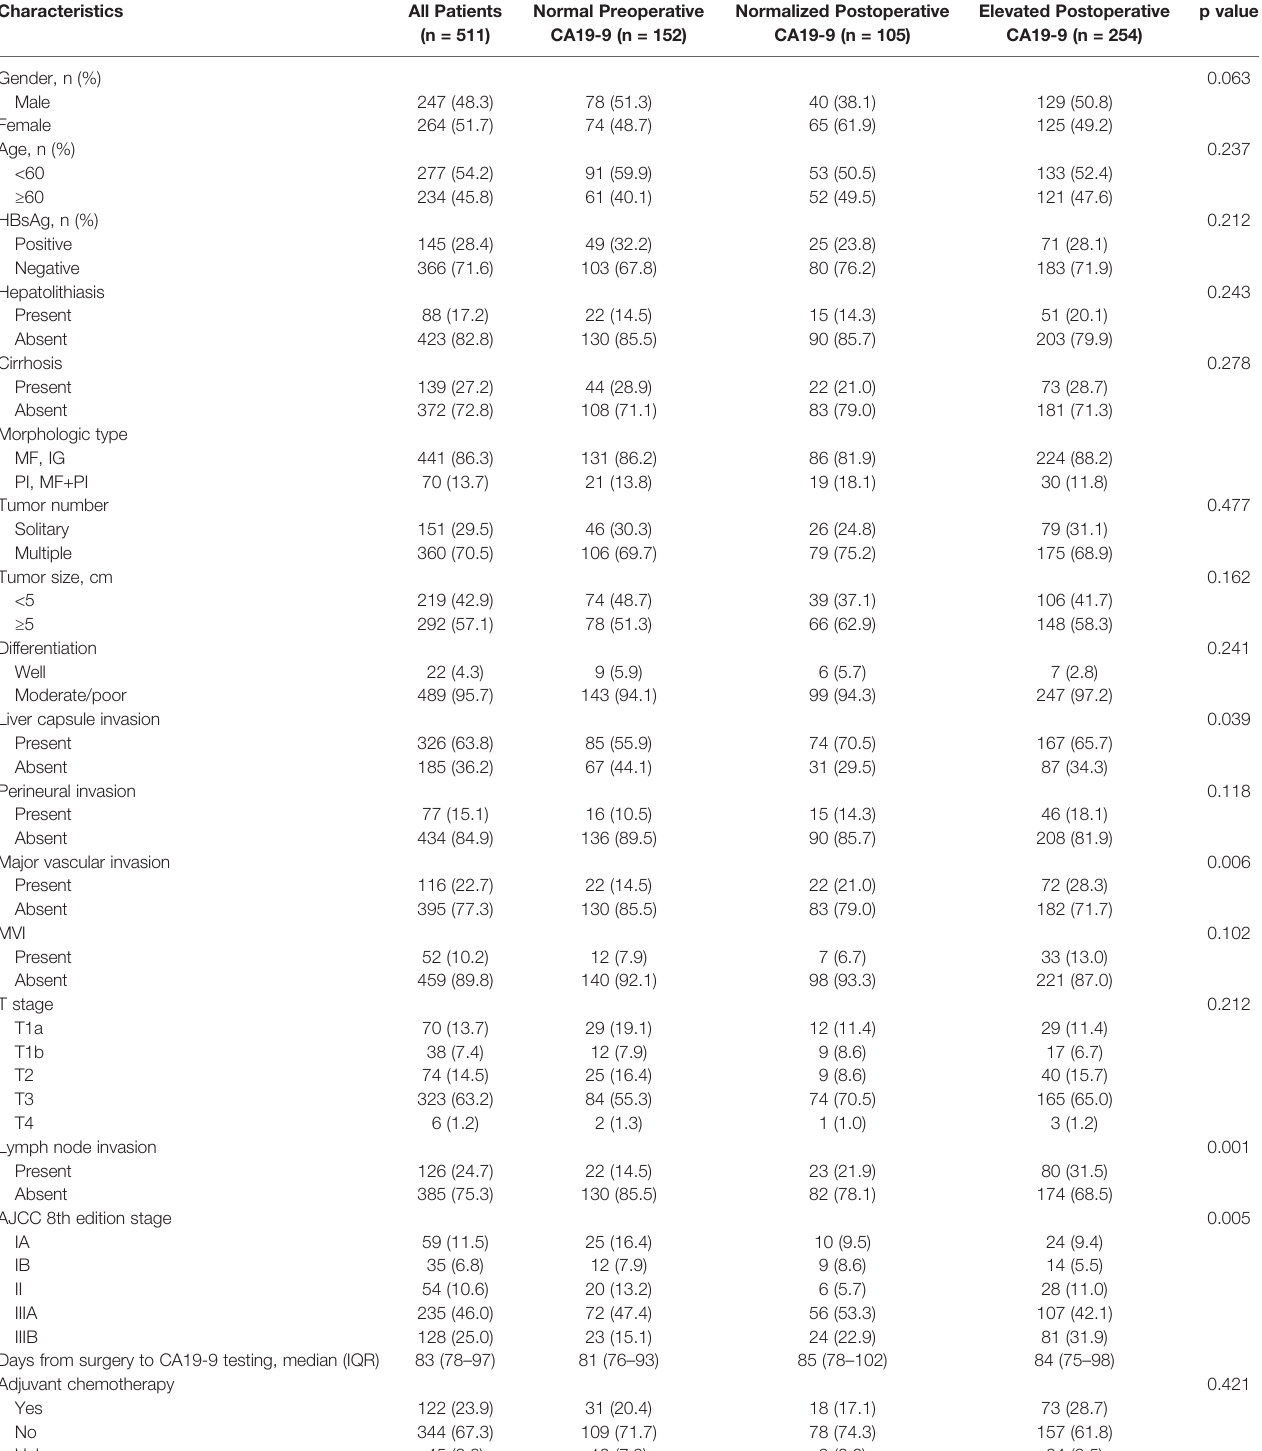
TABLE 1 | Characteristics of patients.